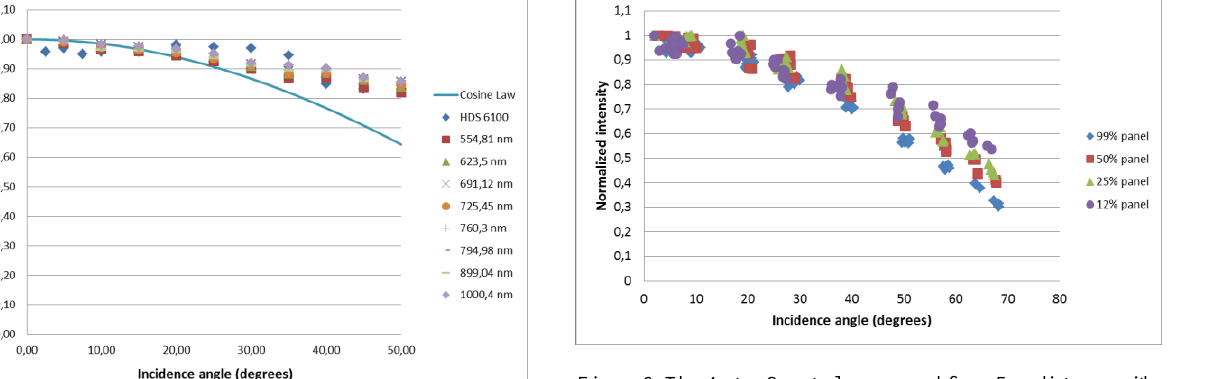
Figure 6. The 4-step Spectralon scanned from 5 m distance with incident angles ranging from 0 ⁰ to 82 ⁰